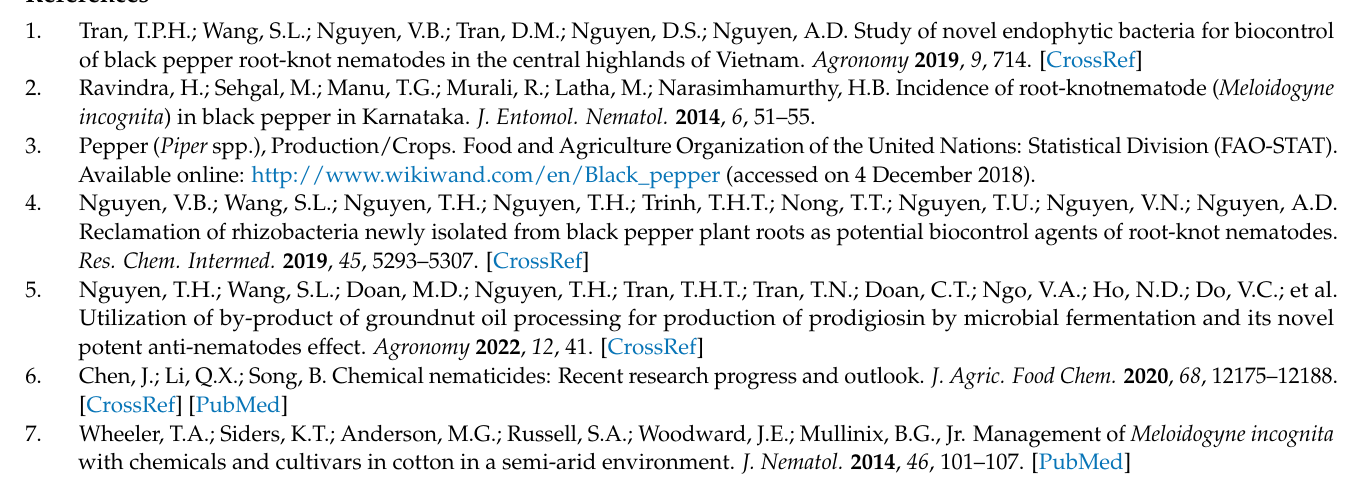
Figure S6: HSQC spectrum of compound 2 (hexahydropyrrolo [1,2-a] pyrazine-1,4-dione); Figure S7: HSQC spectrum of compound 2 (hexahydropyrrolo [1,2-a] pyrazine-1,4-dione); Figure S8: HR-ESI-MS spectrum of compound 2 (hexahydropyrrolo [1,2-a]